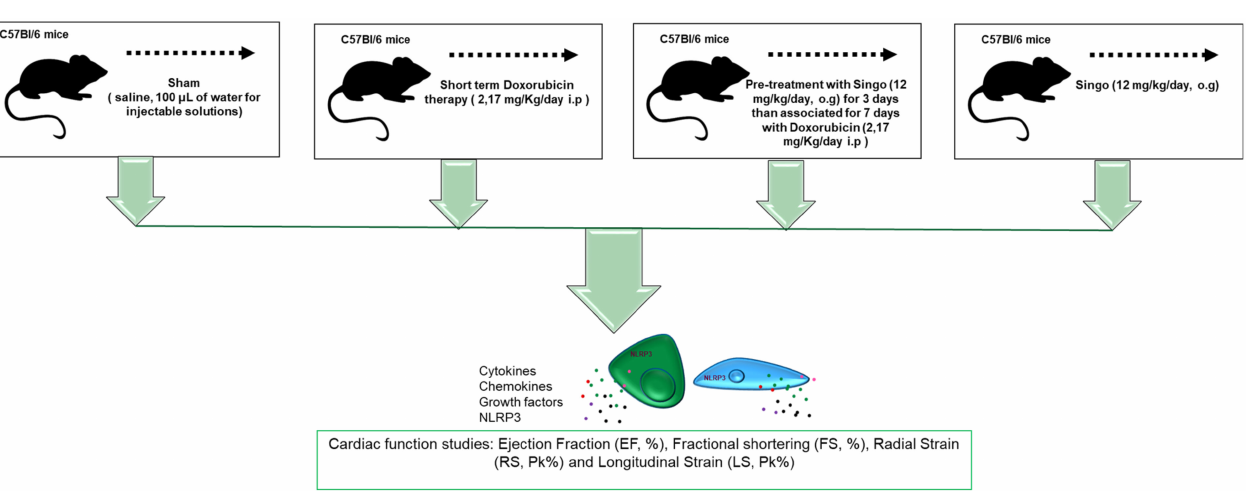
Figure 1. Overall design of the preclinical study of DOXO-induced cardiotoxicity and cardioprotective strategy based on oral gavage of Singo, a nutraceutical combination of Reishi, Spirulina and Moringa at 12